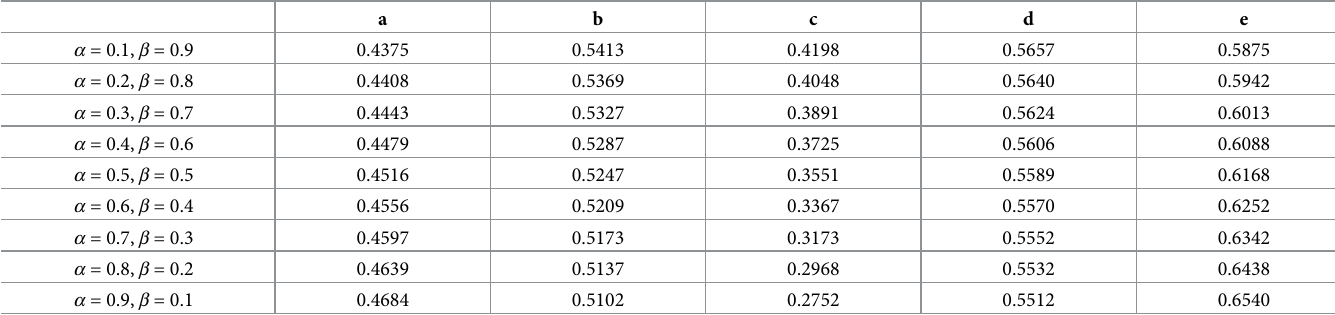
Table 9. The relative closeness degree based on α and β from 0 to